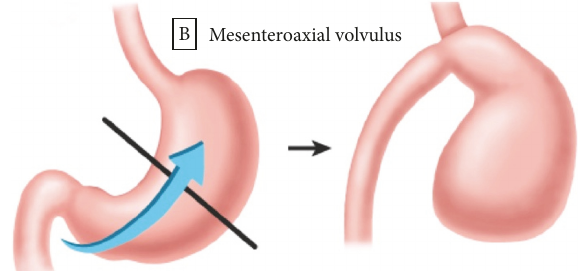
Figure 2: Mesenteroaxial gastric volvulus. The stomach rotates around its short axis through a perpendicular line connecting the greater and lesser curvatures of the stomach. The antrum becomes displaced above the gastroesophageal junction.